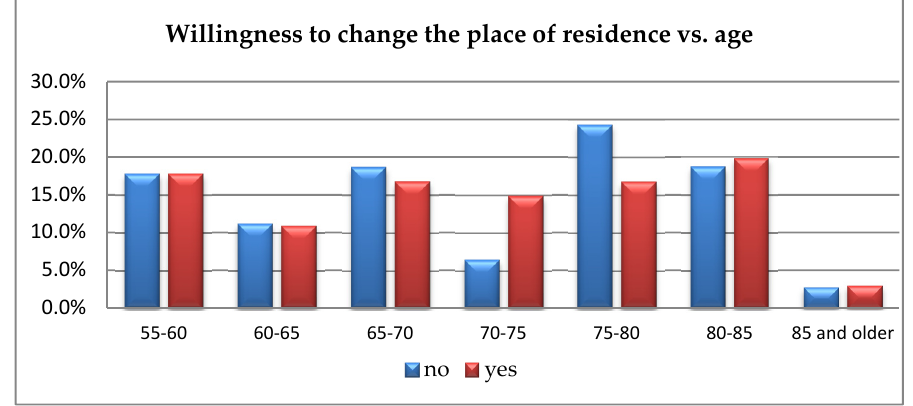
Figure 3 . Willingness to change the place of residence in order to purchase an apartment adapted to one’s mobility needs, free from architectural and technical barriers depending on residents’ age.